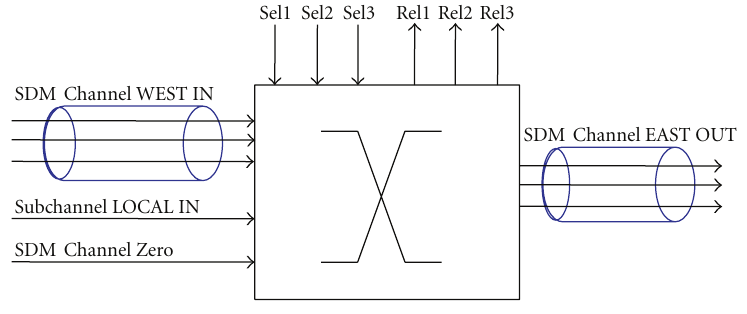
Figure 20: Block diagram SDM switch EAST.